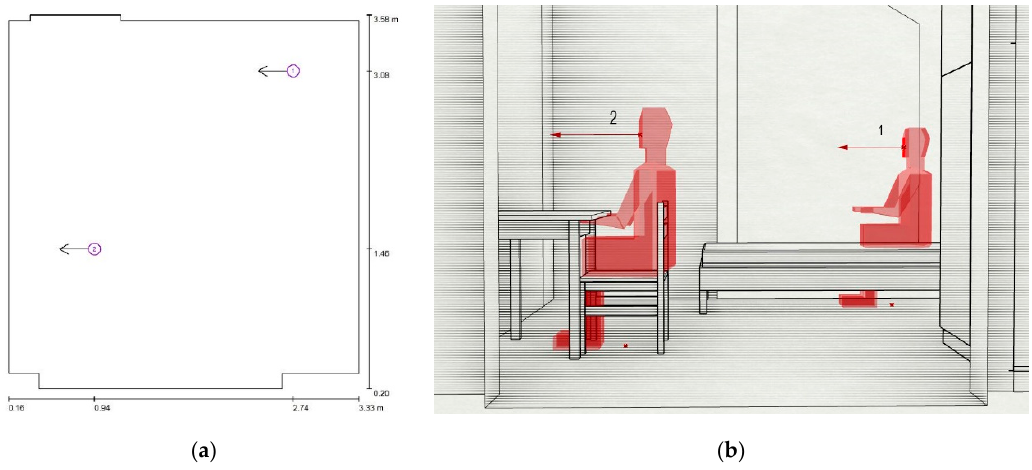
Figure 5. Spots for evaluation of sDGP in Bedroom 3: ( a ) plan and ( b ) perspective view.